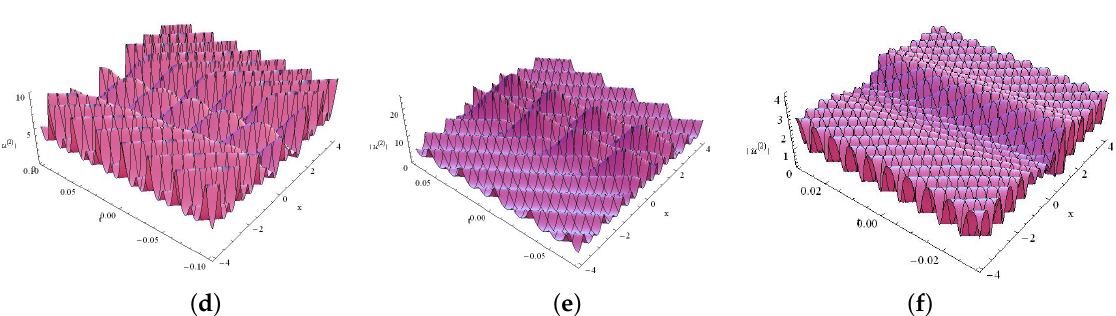
Figure 13. Interaction solution of breather and periodic wave for Equation (5). For the focusing case with (cid:101) = 1, a = − 1, b = 2: ( a ) interaction of M-shaped double-peak-breather and M-shaped periodic wave with λ 1 = 1 , λ 2 = − 3; ( b ) interaction of dark breather and M-shaped periodic wave with 3 λ 1 = 1, λ 2 = − 3; ( c ) interaction of dark breather and M-shaped periodic wave with λ 1 = 1 + i λ 2 = − 3. For the defocusing case with (cid:101) = 1, a = 1, b = 2: ( d ) interaction of bright-bright breather and W-shaped periodic wave with λ 1 = 1 , λ 2 = − 3; ( e ) interaction of double-peak breather and W- 3 shaped periodic wave with λ 1 = 1, λ 2 = − 3; ( f ) interaction of bright-bright breather and M-shaped periodic wave with λ 1 = 1 + i , λ 2 = − 5